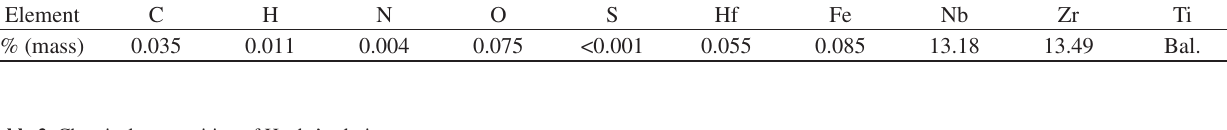
Table 2. Chemical composition of Hanks’ solution.